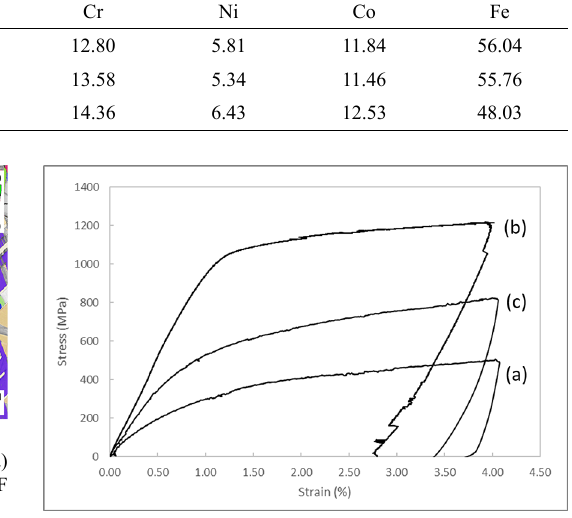
Figure 5. Stress x Strain curves: (a) ST, (b) ST + 2ECAE + 650ºC, (c) ST + 2ECAE +